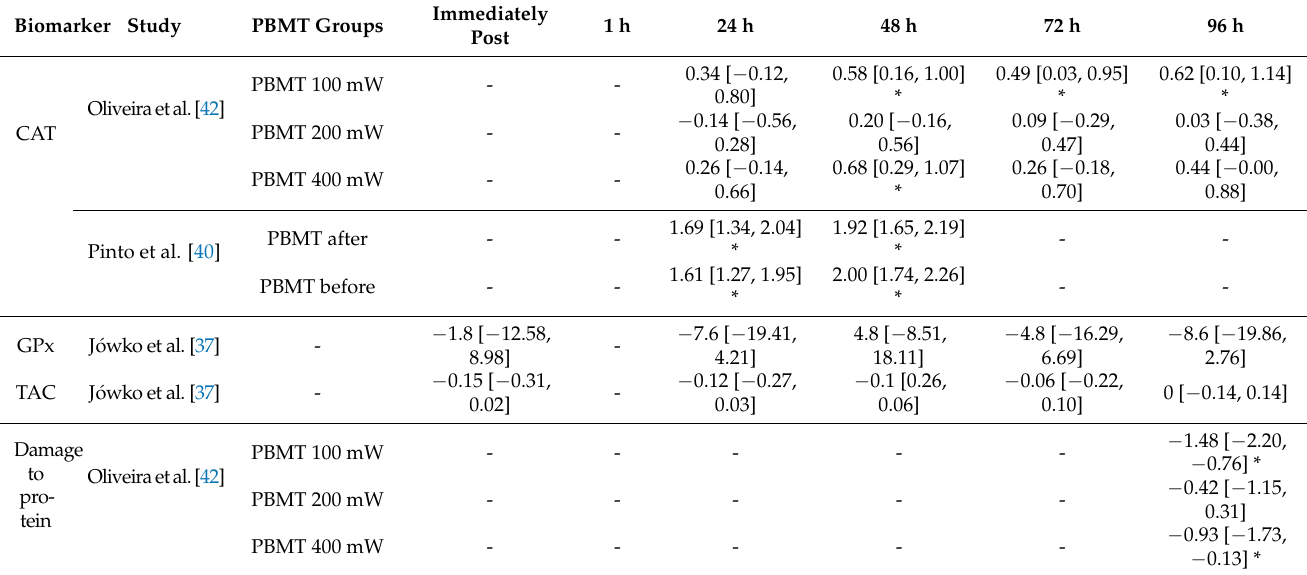
Table 4. Mean difference and 95% confidence interval between changes of PBMT versus placebo at time-points that were not